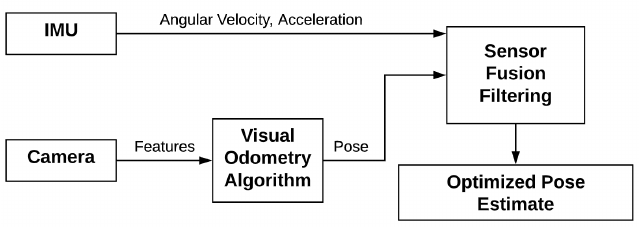
Figure 1. Visual-Inertial Odometry feature matching principle and IMU (Inertial Measurement Unit) measurements during motion [28].